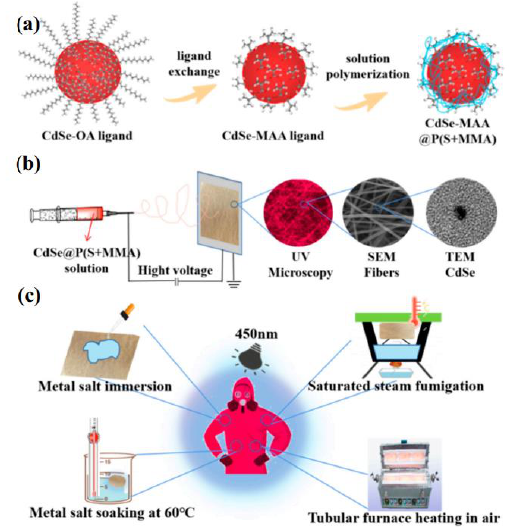
Figure 1. ( a ) Scheme of the oleic acid ligand exchange with methacrylate acid followed by solution polymerization; ( b ) schematic diagram of the electrospinning process; ( c ) possible practical applica- tions of the luminescent electrospun hybrid fibers.